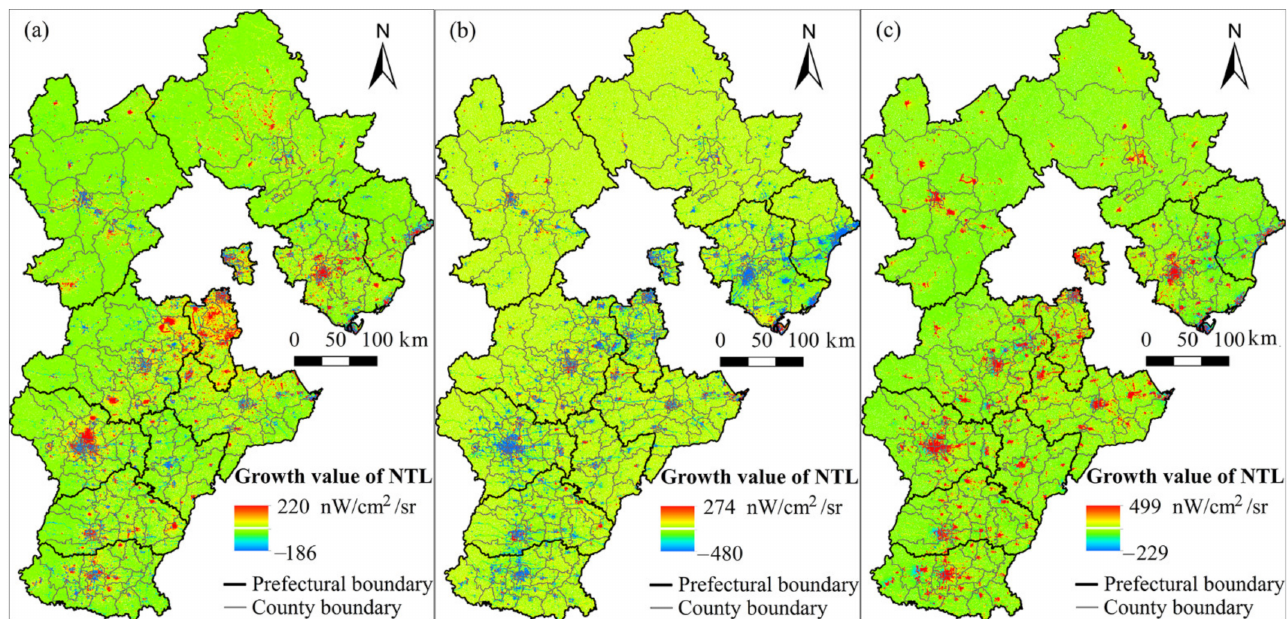
Figure 9. The pixel-by-pixel radiance difference maps of monthly NTL for ( a ) January 2020 vs. December 2019, ( b ) January 2021 vs. December 2020, and ( c ) November 2021 vs. October 2021 over the entire Hebei